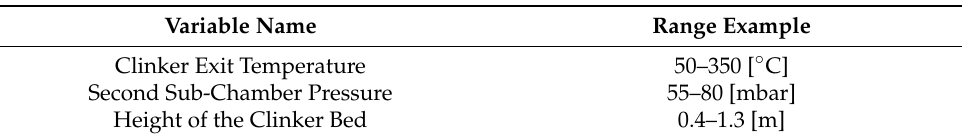
Table 6. Grate cooler APC system: CVs.